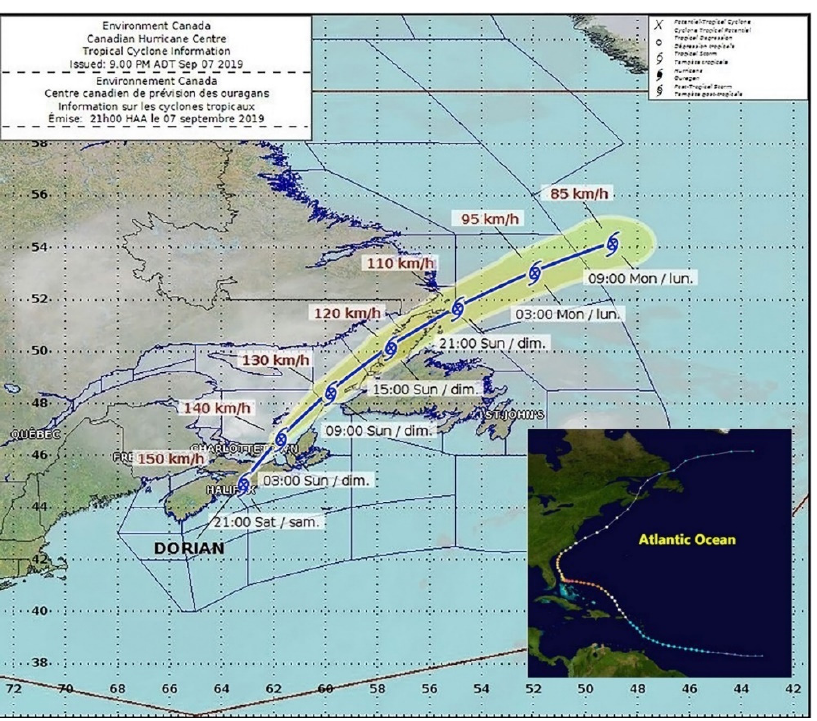
Figure 2. Path of Hurricane Dorian in Atlantic Canada provided by Environment Canada with NASA Inset Map of Storm Track.